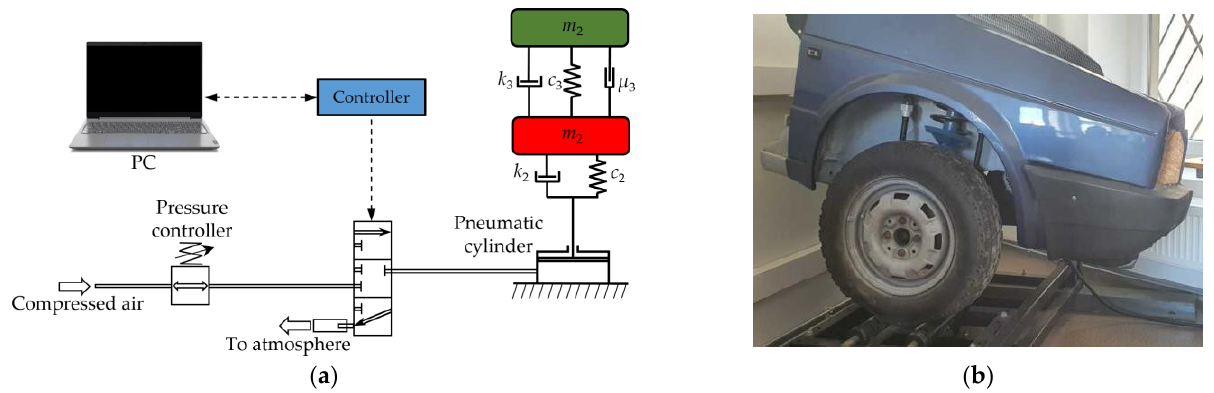
Figure 14. Equipment simulating the road surface effects: ( a ) scheme; ( b ) quarter-car test bench.